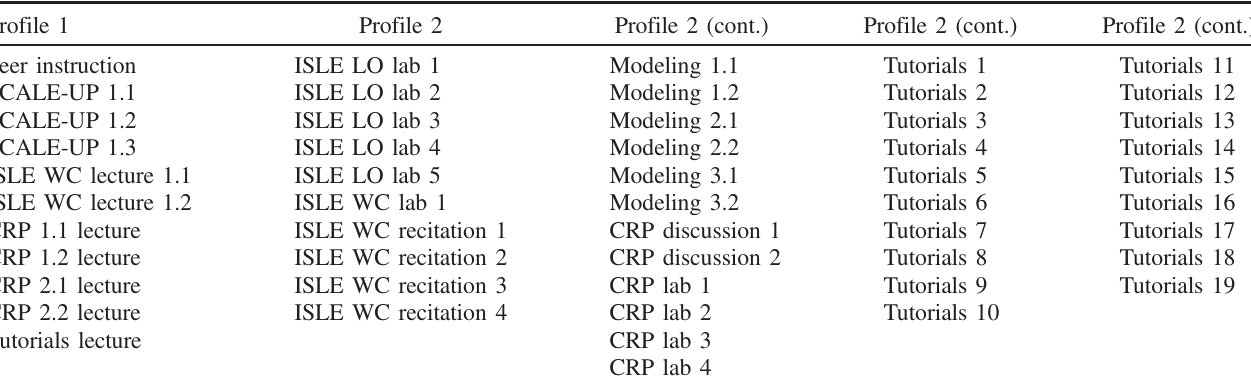
TABLE V. Model 1 profile assignment, 2 profiles. Profile 1 is red on the top panel of Fig. 3, while profile 2 is blue. ISLE had two sets of observations, the whole-class implementation (WC) and the lab-only implementation (LO).